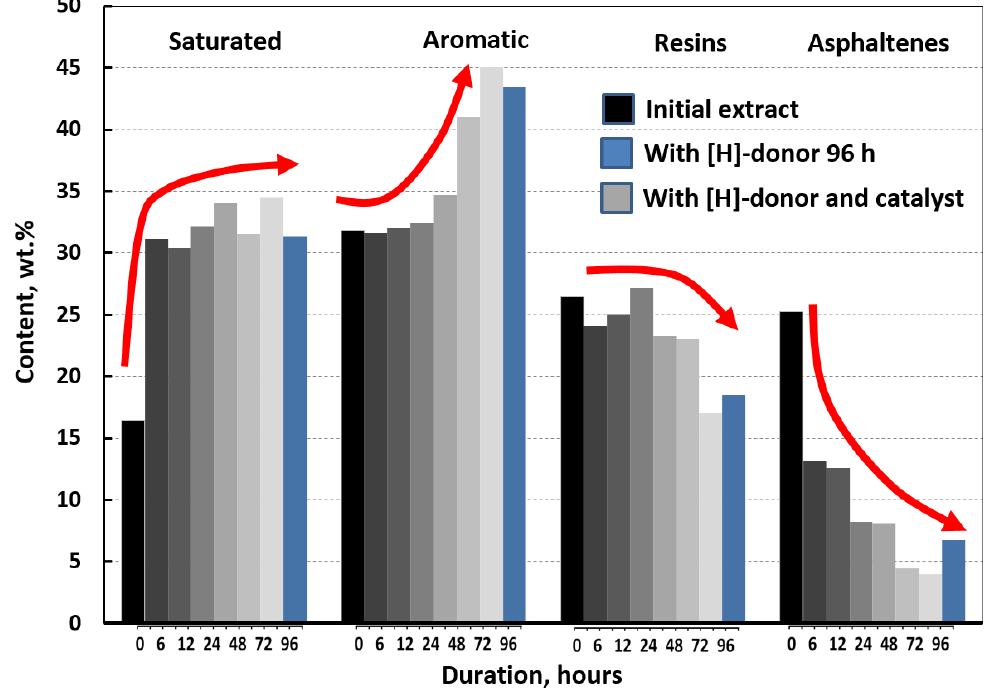
Figure 4. SARA analysis of core extracts depending on duration of catalytic aquathermolysis.